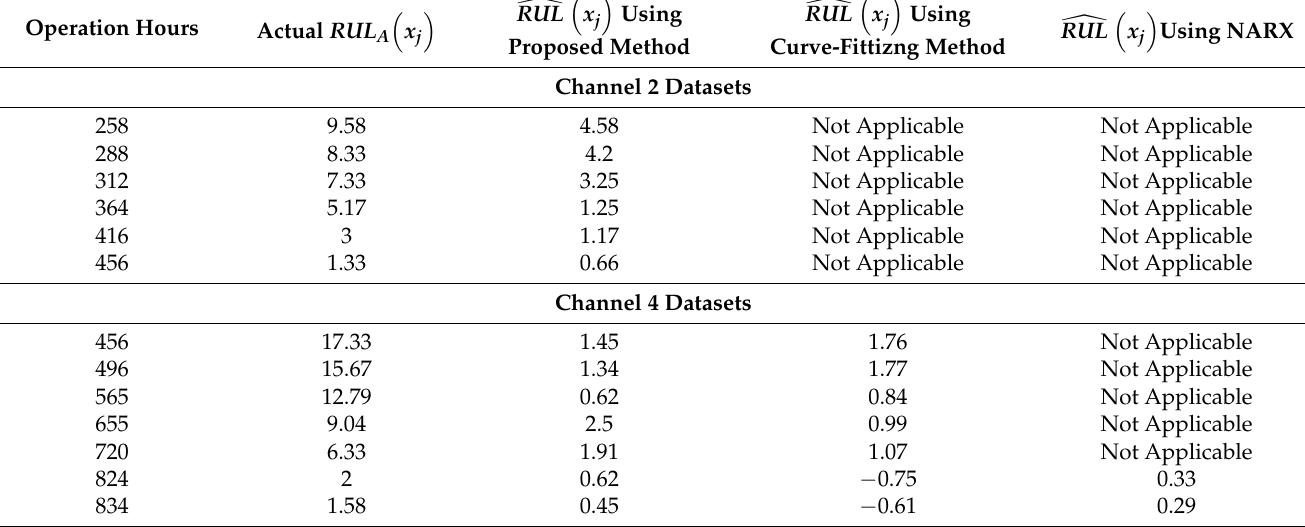
Table 5. Actual and predicted RULs in terms of Weights.